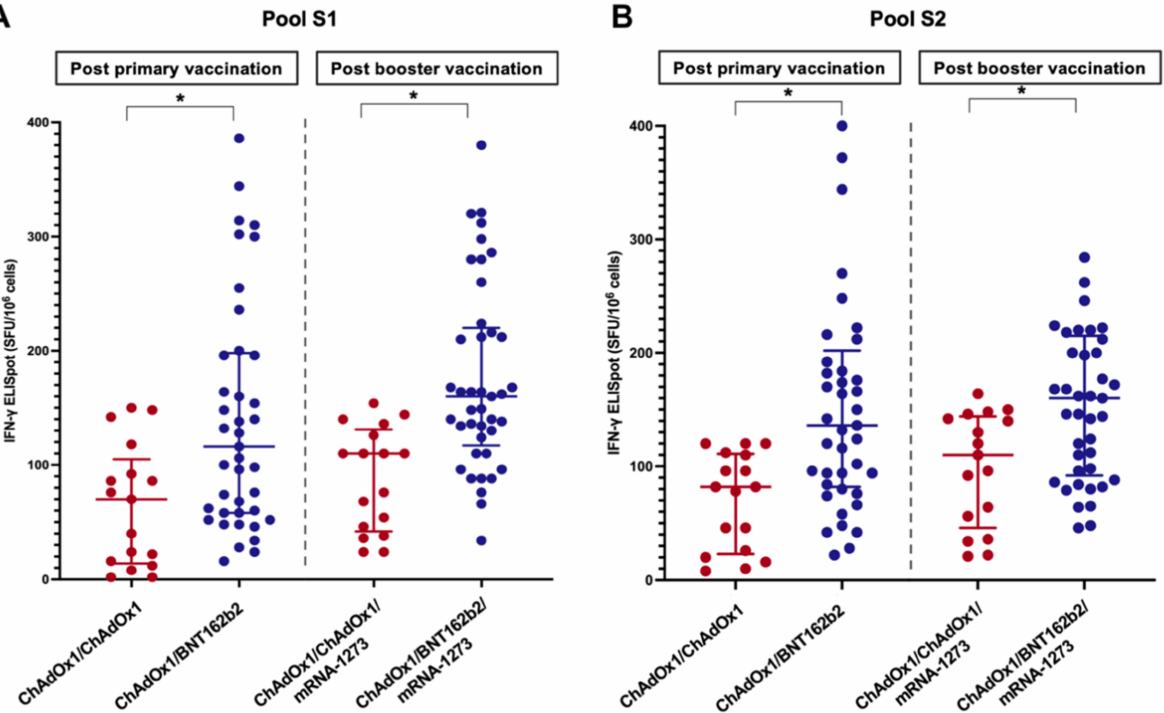
Figure 4. Cellular response to spike-specific T-cell responses among LT recipients four weeks follow- ing the primary immunisation and booster vaccine ( A ) Pool S1, ( B ) Pool S2 (*, statistically